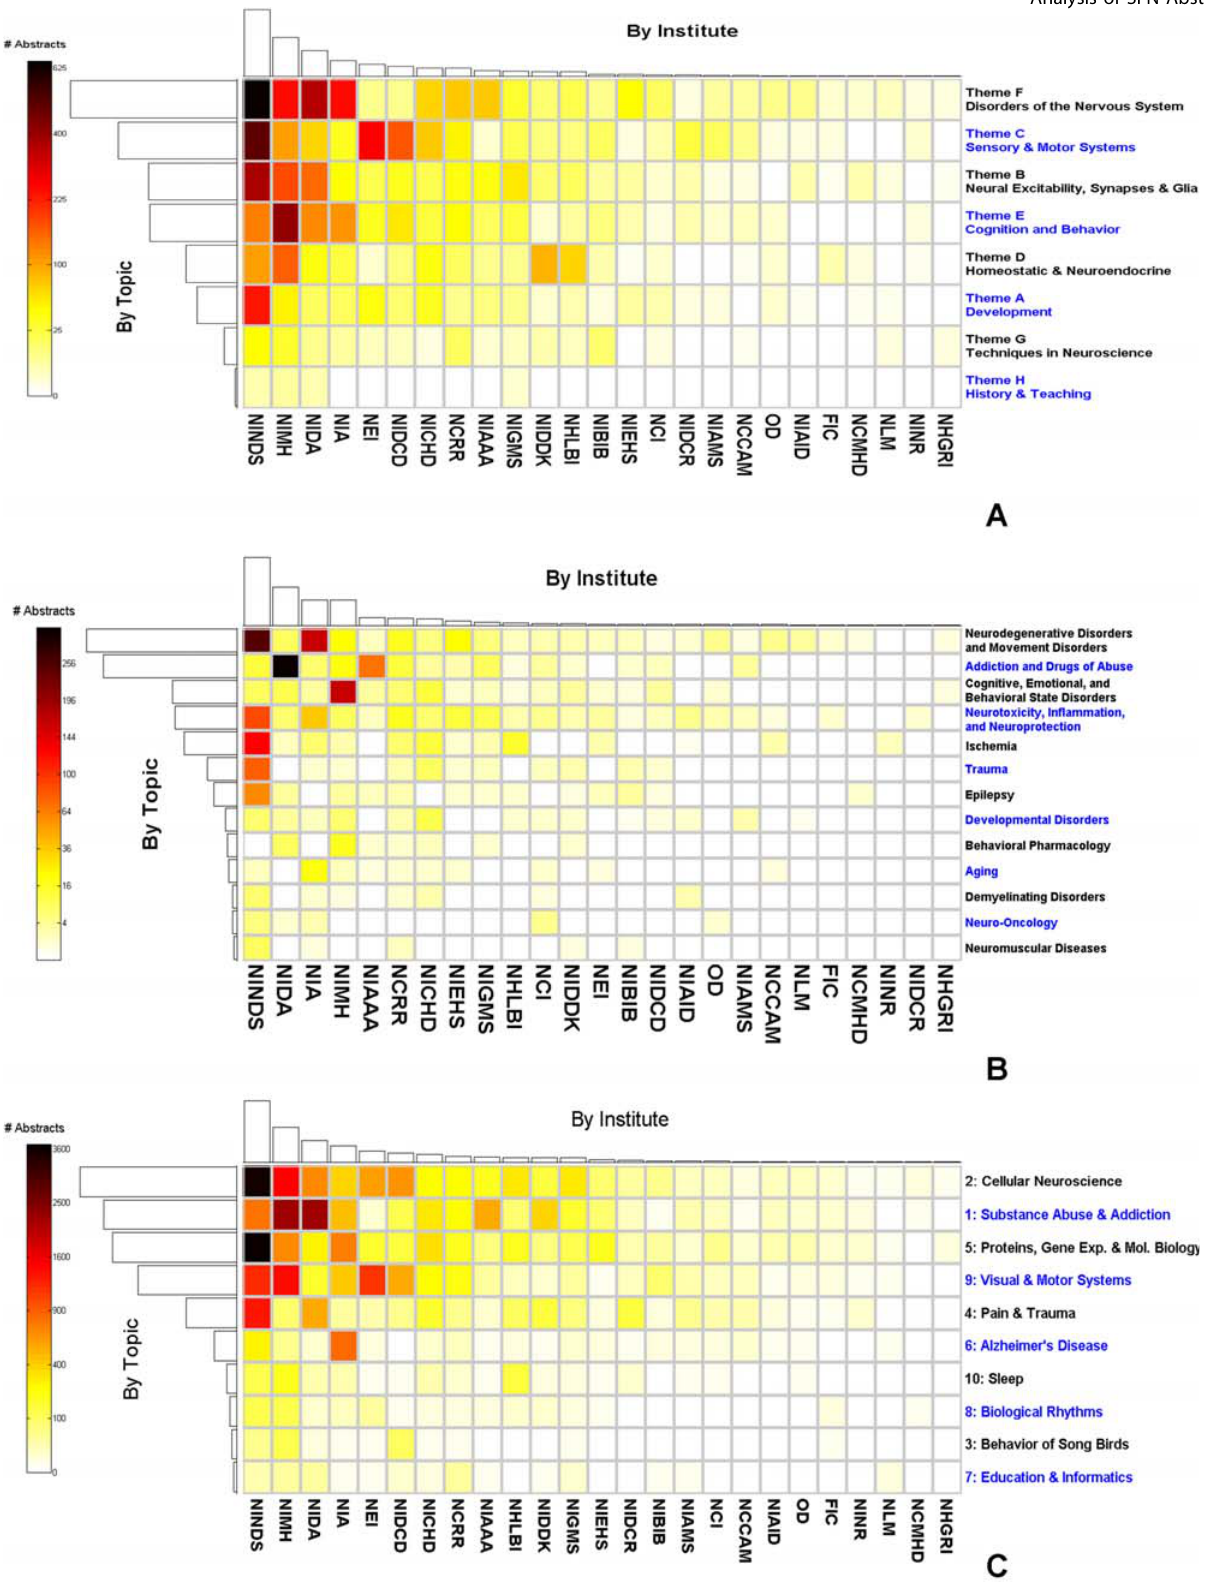
Figure 12. (A) Distribution of NIH funding across institutes and themes for the 2006 meeting abstracts. (B) Distribution of NIH funding across institutes and Theme F subthemes for the 2006 meeting abstracts. (C) Distribution of NIH funding across institutes and topic clusters for 2001–2006 meeting abstracts. The color of an individual entry in the ‘‘image grid’’ indicates the number of abstracts from a particular theme (for A), subtheme (for B), or topic cluster (for C, as determined by NCuts graph partitioning) that were funded by a particular NIH institute. Colors are scaled non-linearly for greater contrast. The ‘‘bar plots’’ on each axis indicate the total number of abstracts funded by a particular institute (top) or contained in a particular topic group (left). Both rows and columns have been sorted by total number of abstracts. doi:10.1371/journal.pone.0002052.g012 PLoS ONE |